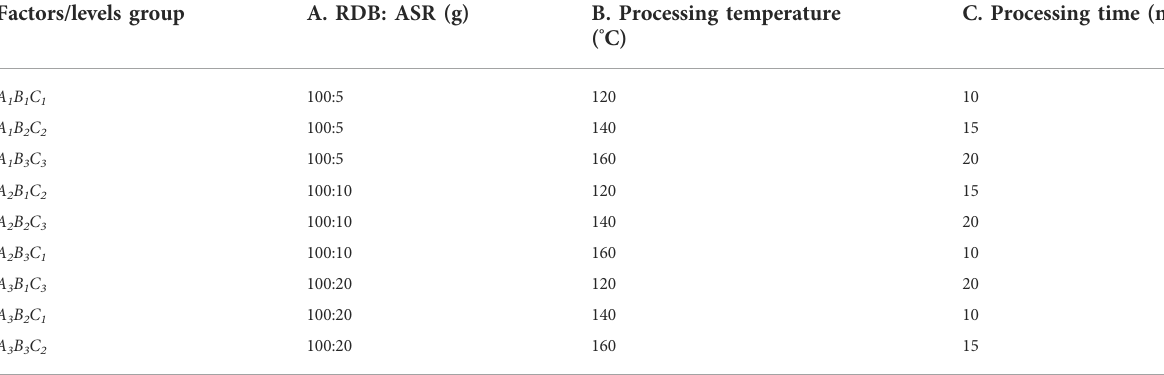
TABLE 1 The L9 (3 4 ) orthogonal experimental design table of ASR-processed